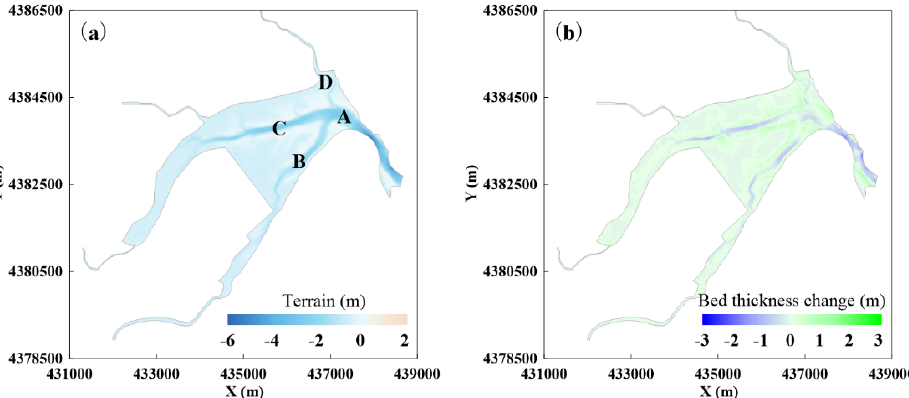
Figure 6. ( a ) Bathymetric map of the QL system on 1 January 1970; ( b ) bed thickness change from 1950 to 1969 for the QL system.